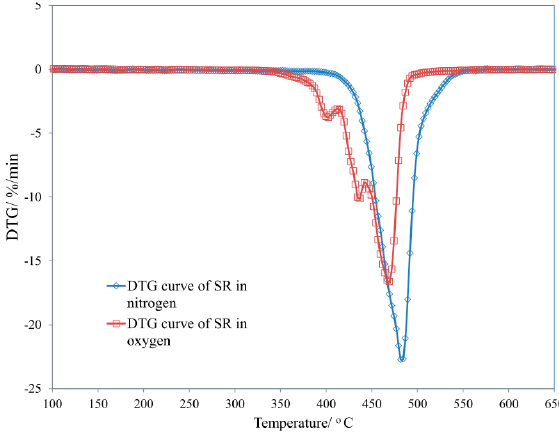
Figure 2. DTG curves of silicone rubber in the air and nitrogen atmosphere.